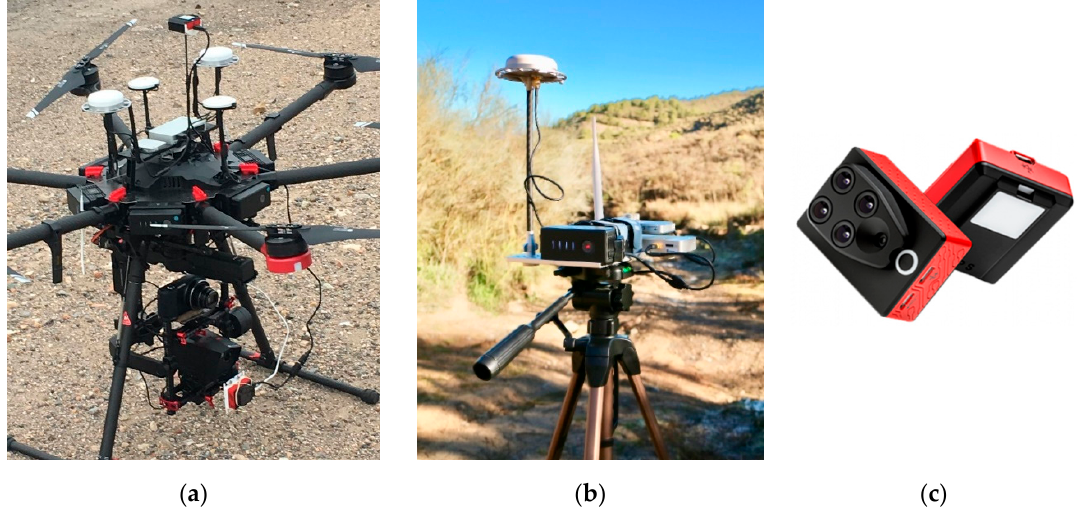
Figure 3. Unmanned Aerial Vehicle (UAV) system: ( a ) DJI Matrice 600 Pro with a Parrot Sequoia multispectral camera onboard and D-RTK navigation antennas; ( b ) base station of the D-RTK Global Navigation Satellite System (GNSS) positioning and navigation device; ( c ) multi-spectral Sequoia cam with a sunshine